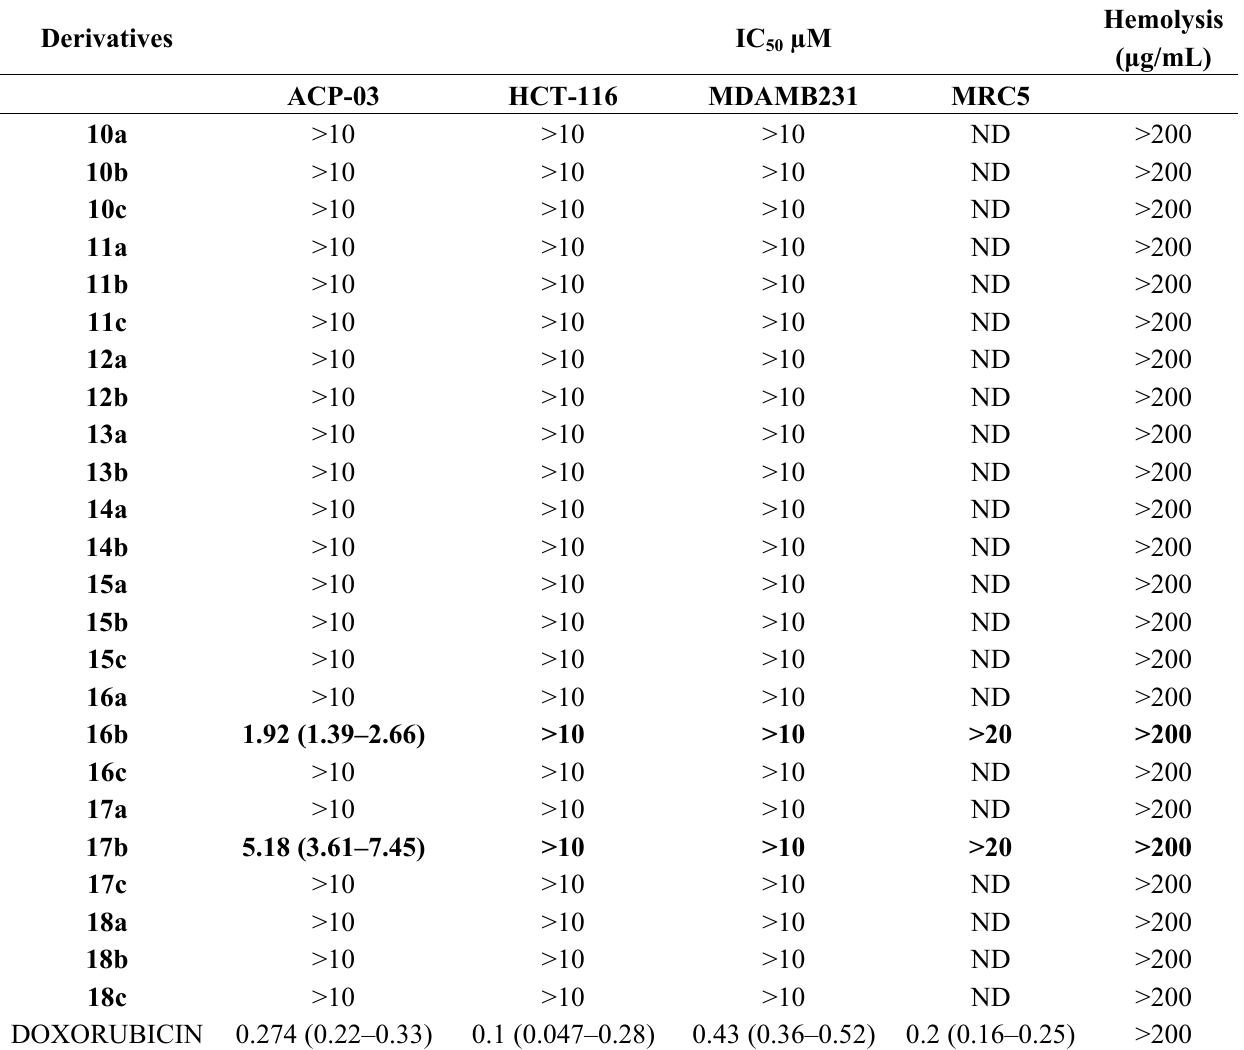
Table 2. Cytotoxic activity of 10 – 18 on cancer cell lines (ACP-03, HCT-116 and MDA- MB-231), a normal fibroblast cell line (MRC-5) and erythrocytes (to measure